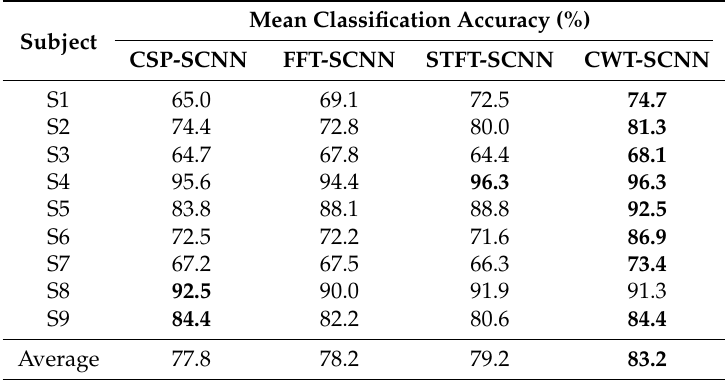
Table 4. The classification results of the CWT-SCNN, CSP-SCNN, fast Fourier transform (FFT)-SCNN, and short time Fourier transform (STFT)-SCNN methods.